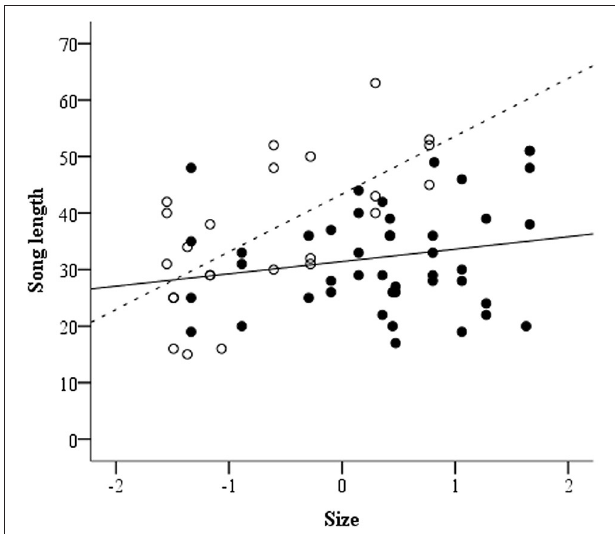
FIGURE 2 | Relationship between female size and song length in mainland (black circles and solid line; R 2 = 0.04) and island (white circles and dashed line; R 2 = 0.44)